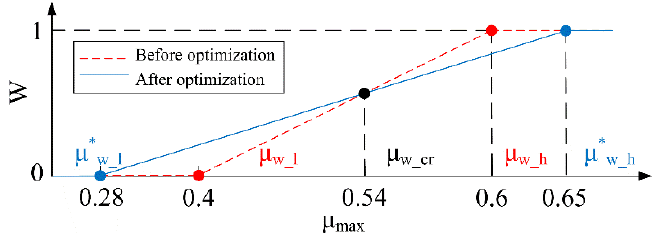
Figure 13. Change of the W function before and after optimization.